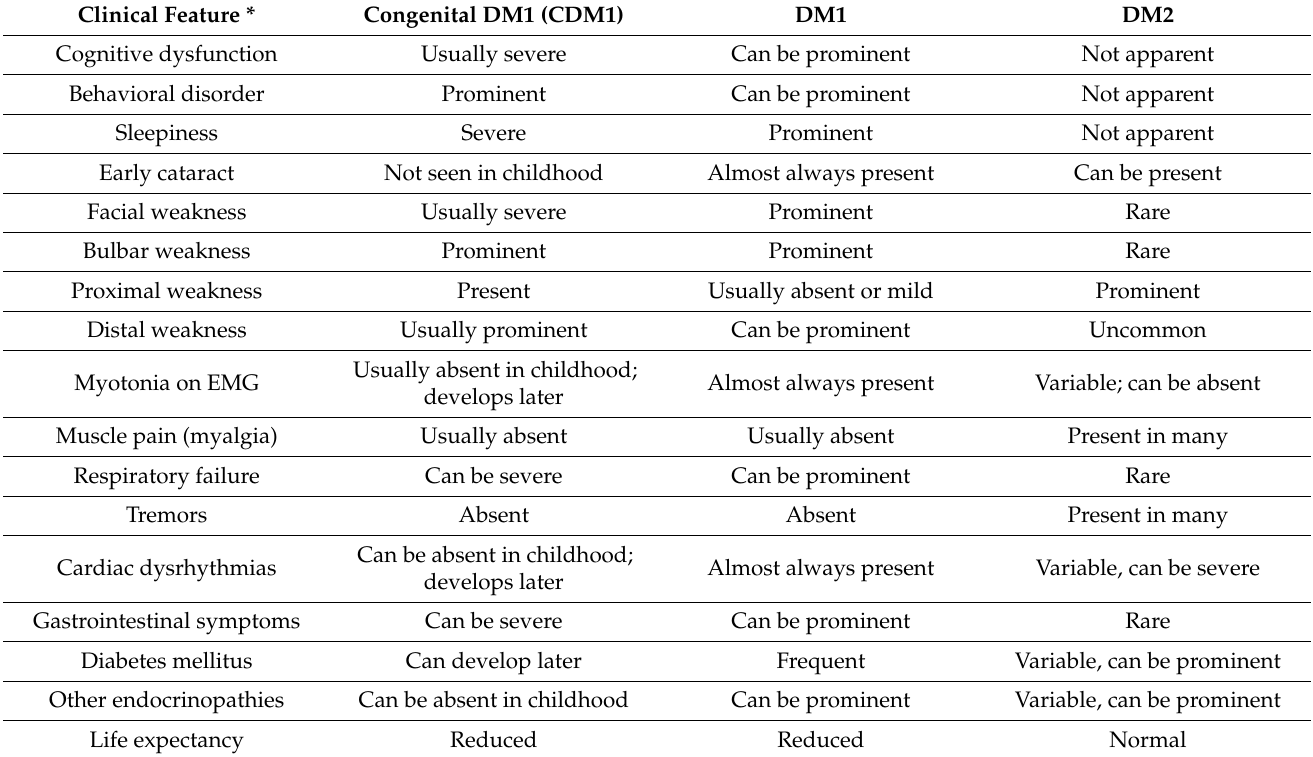
Table 1. Clinical manifestations of myotonic dystrophies type 1 (DM1), congenital DM1, and